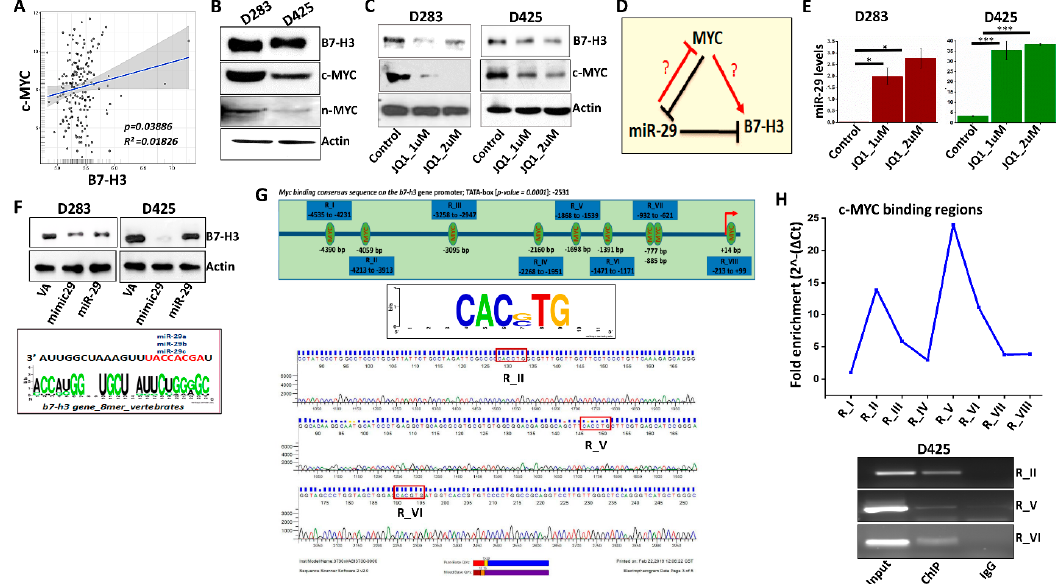
Figure 2. B7-H3 expression is regulated by Myc and miR-29. ( A ) mRNA transcript levels of Myc and B7-H3 in MB patient samples from Northcott dataset. ( B ) Protein expression levels of B7-H3, c-Myc and n-Myc in D283 and D425 cells determined by western blotting with Actin as a loading control. ( C ) Western blot analysis of c-Myc and B7-H3 protein levels in D283 and D425 cells treated with JQ1 (1 µ M and 2 µ M) incubated for 24 h. Actin used as loading control. ( D ) Schematic representation of Myc-miR-29-B7-H3 regulatory axis. ( E ) miR29 transcript levels in D283 ( left ) and D425 ( right ) cells treated with JQ1, 24 h incubation as determined by RT-PCR ( n = 4 for each group). ( F ) Western blotting showing B7-H3 expression in D283 ( left ) and D425 ( right ) cells transfected with scrambled vector (VA), miR-29 mimic (mimic29) or miR-29b / a plasmid (miR-29). Cells were harvested 48 h after transfection, Actin used as loading control. ( Bottom ) Analysis of 3’ UTR of B7-H3 mRNA with consensus binding sequence homology with miR-29 isoforms. Developed from microRNA.org database. ( G ) B7-H3 promoter analysis showing 9 potential Myc-binding sites (CAC(GC)TG; p = 0.0001)